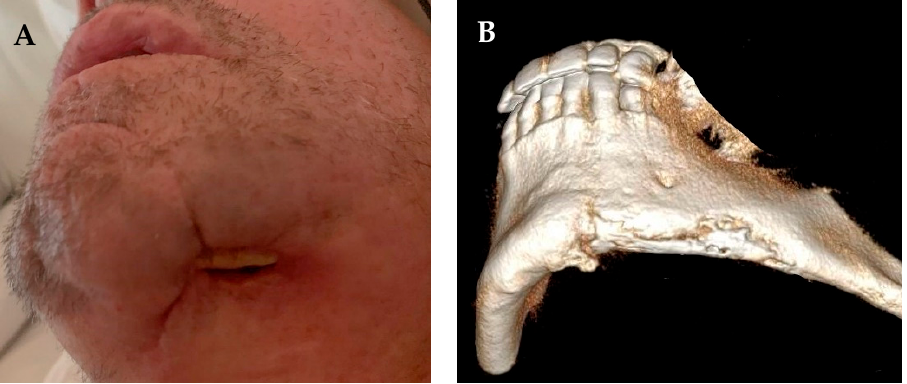
Figure 1. Mandibular ORN following mandibulotomy and radiotherapy for squamous cell carcinoma of the base of tongue. ( A ) clinical image demonstrating dehiscence of the soft tissue and exposure of necrotic bone on the inferior border of the left mandibular parasymphysis and body and ( B ) a 3-dimensional reconstruction of the CT demonstrating sequestration of the inferior mandibular border.